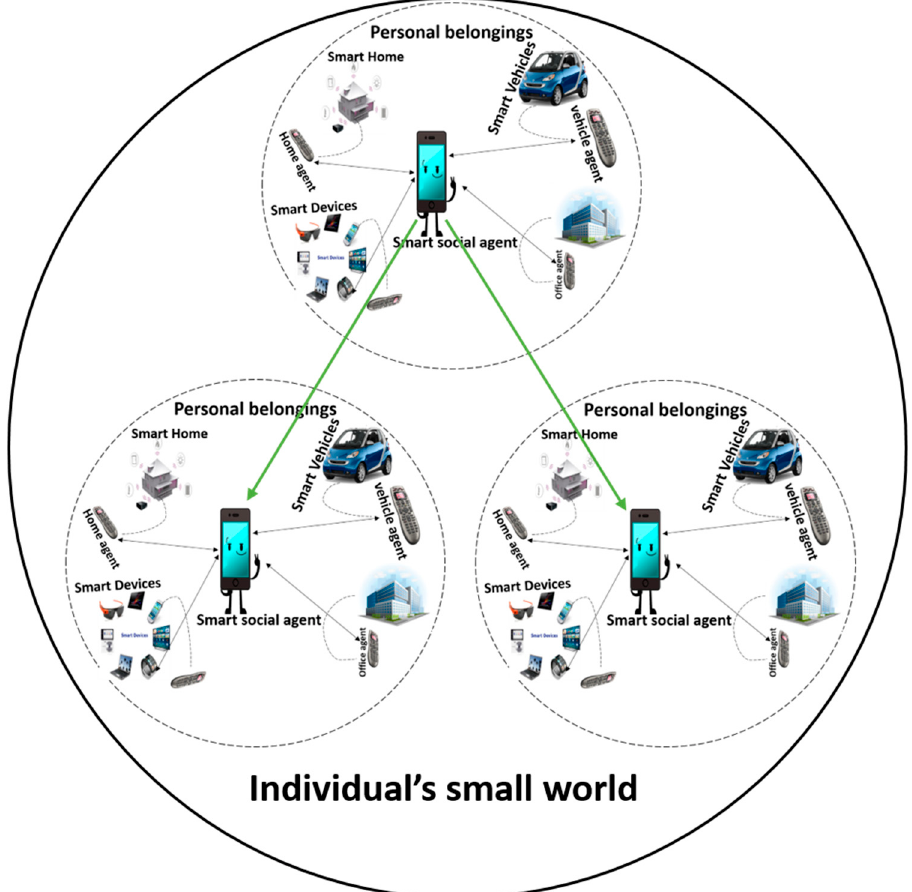
Figure 4. A pictorial representation of friendship in a small world network.